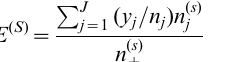
Figure 1. Hawaiian green turtle ( Cheloniamydas ) with fibropa- pillomatosis (FP) on the seafloor in Pupukea Marine Life Conservation District, North Shore, Oahu. Evidence suggests that this disease, characterized by external epithelial tumor masses (white arrows), is caused by a herpesvirus. Photo: Lacey Price/Marine Photobank, taken April 2008.